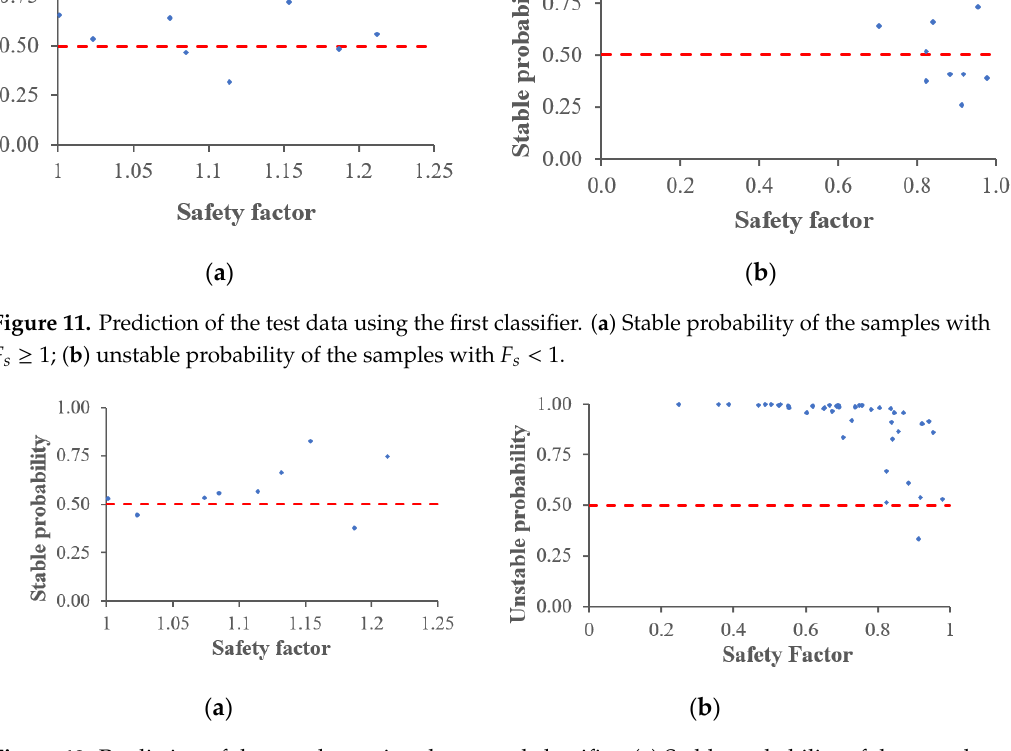
Figure 12. Prediction of the test data using the second classifier. ( a ) Stable probability of the samples with 𝐹 𝑠 ≥ 1 ; ( b ) unstable probability of the samples with 𝐹 𝑠 < 1 .